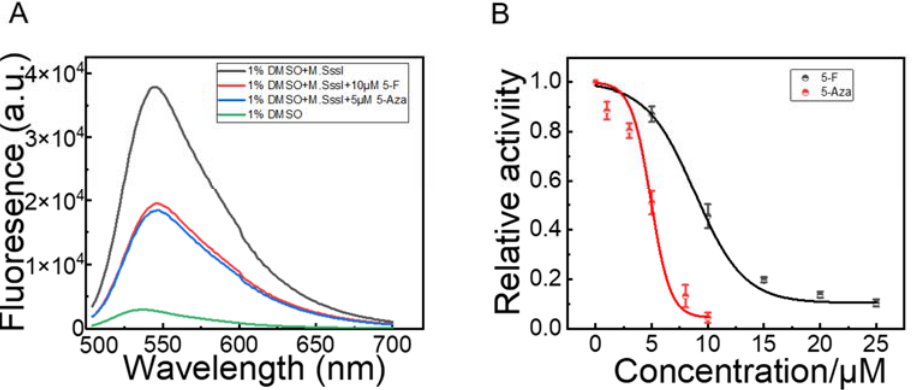
Figure 4. Inhibitory effect analysis of MTase inhibitors. ( A ) Fluorescence intensity with 1% DMSO and M.SssI or 10 µM 5-F and M.SssI or 5 µM 5-Aza and M.SssI or without M.SssI. ( B ) M.SssI activity with different concentrations of 5-F and 5-Aza. The concentration of M.SssI was 100 U/mL.